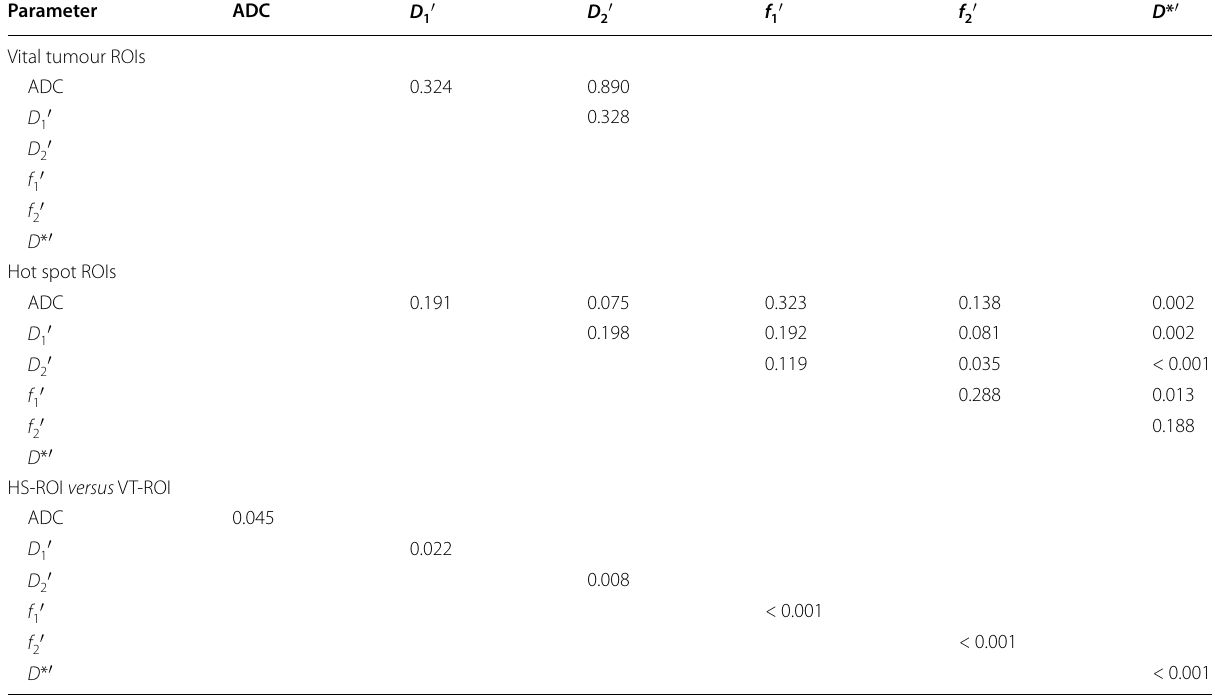
Table 8 Results ( p values) of comparisons between areas under the curve values presented in Table 7 for group B versus group